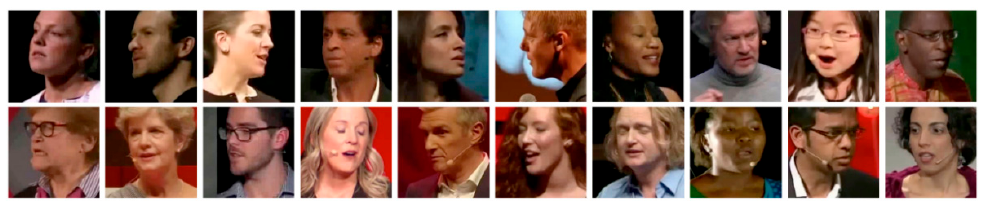
Figure 4. Example data from the LRS3 dataset [26].